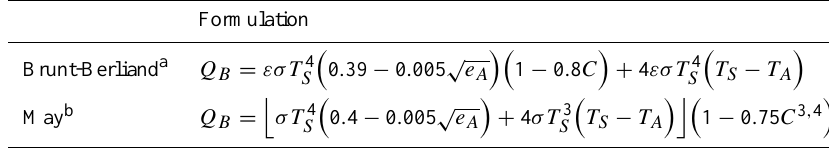
Table 2. Long-wave radiation formulations; (a) Rosati and Miyakoda (1998) and (b) Budyko (1974)